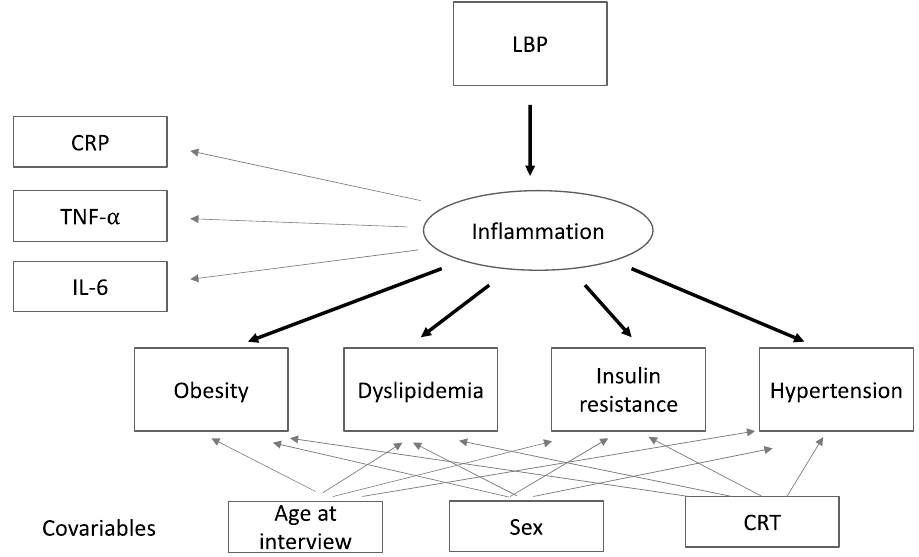
Figure 1. Path diagram corresponding to structural equation model between LBP (biomarker of endotoxemia), inflammation as the latent variable (derived from CRP, TNF-α and IL-6) and cardiometabolic outcomes. The conventional rules of SEM visualization were applied.